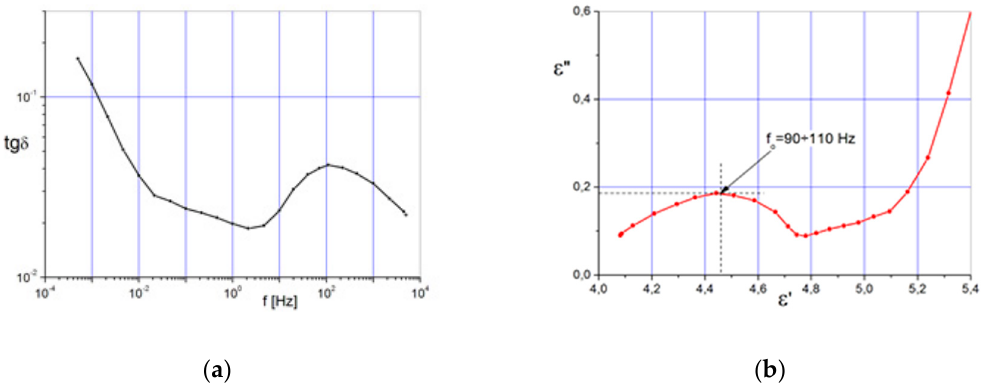
Figure 11. The dependencies measured in the CTF 245 kV bushing: ( a ) tg δ = f(f); ( b ) ε ’’ = f( ε ’).